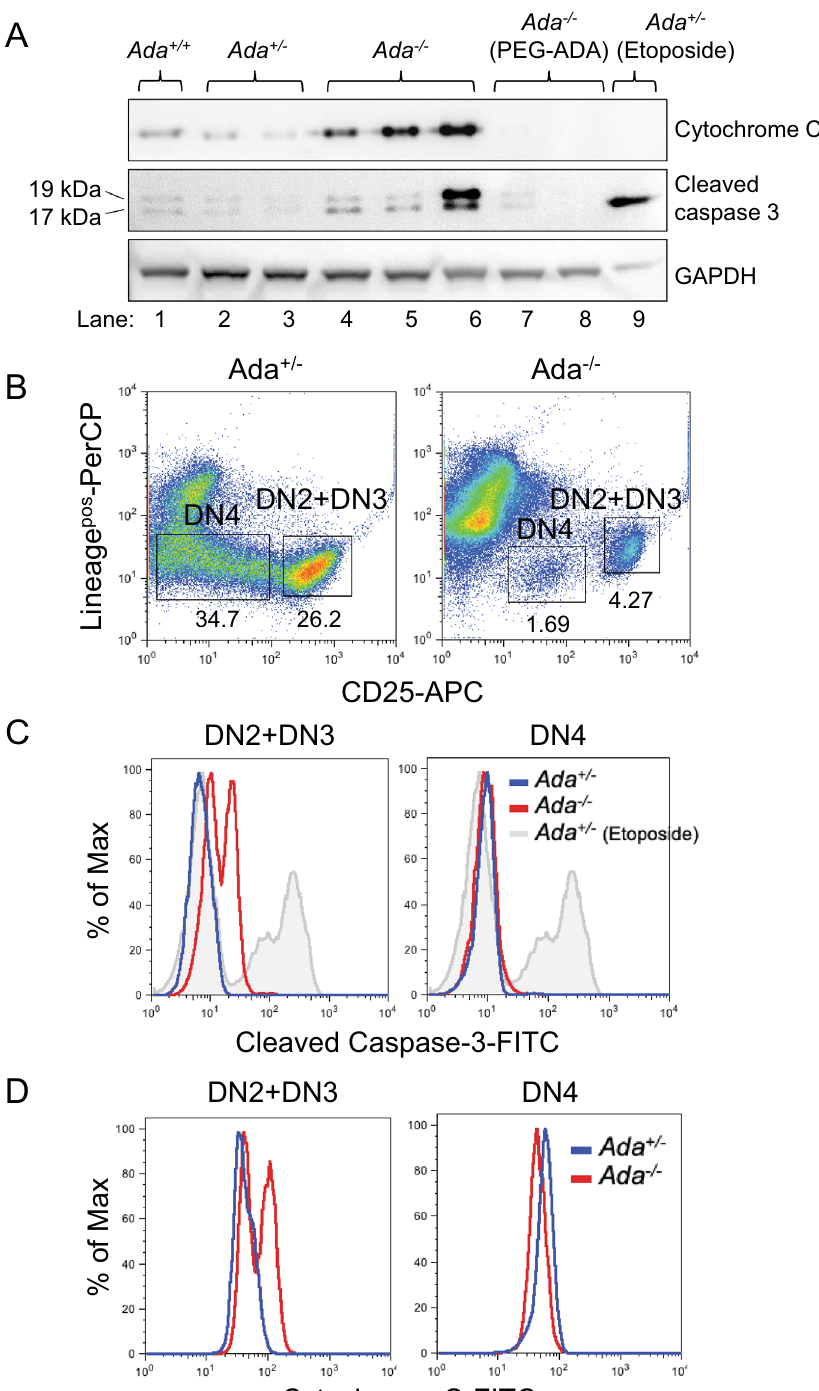
Figure 3. Immature thymocytes from ADA-deficient mice show increased expression of apoptotic markers. ( A ) Western blot analysis of protein lysates of thymi from P14 untreated mice (lane 1–6) and 3-month-PEG- ADA-treated mice (lane 7–8). As positive control for cleaved caspase-3 staining, unfractionated thymocytes were stimulated in vitro with the apoptosis-inducer etoposide (line 9). Anti-GAPDH stain was used as protein loading control. Full-length blots are presented in Supplementary Fig. 11. ( B ) FACS analysis of MACS-enriched Lin neg thymocytes from untreated mice at P14. DN4 (Lin neg , CD25 − ) and DN2 + DN3 (Lin neg , CD25 + ) populations are gated. ( C ) Intracellular staining for cleaved caspase-3 of cell populations shown in (B). Unfractionated Lin neg thymocytes were stimulated in vitro with etoposide as apoptosis positive control. ( D ) Intracellular staining for cytochrome C of cell populations shown in (B). FACS plots in (C) and (D) are representative of two replicate experiments (n = 4,